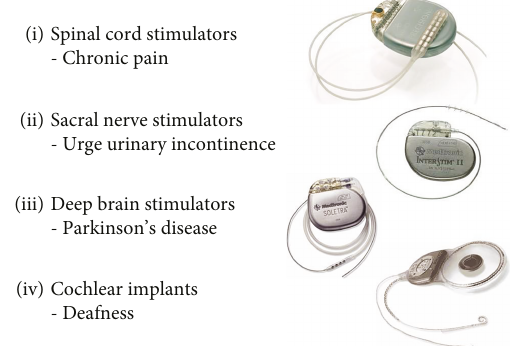
Figure 1: Most currently approved and clinically successful neural prostheses use fairly bulky hermetic titanium cans with multiple feedthroughs and polymerically encased fl exible leads to relatively large platinum-alloy electrodes, similar to cardiac pacemakers of the